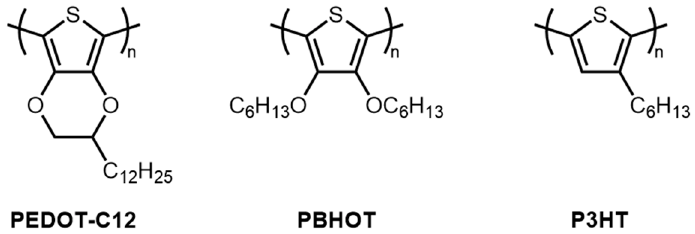
Figure 3. The polymers examined in this work.